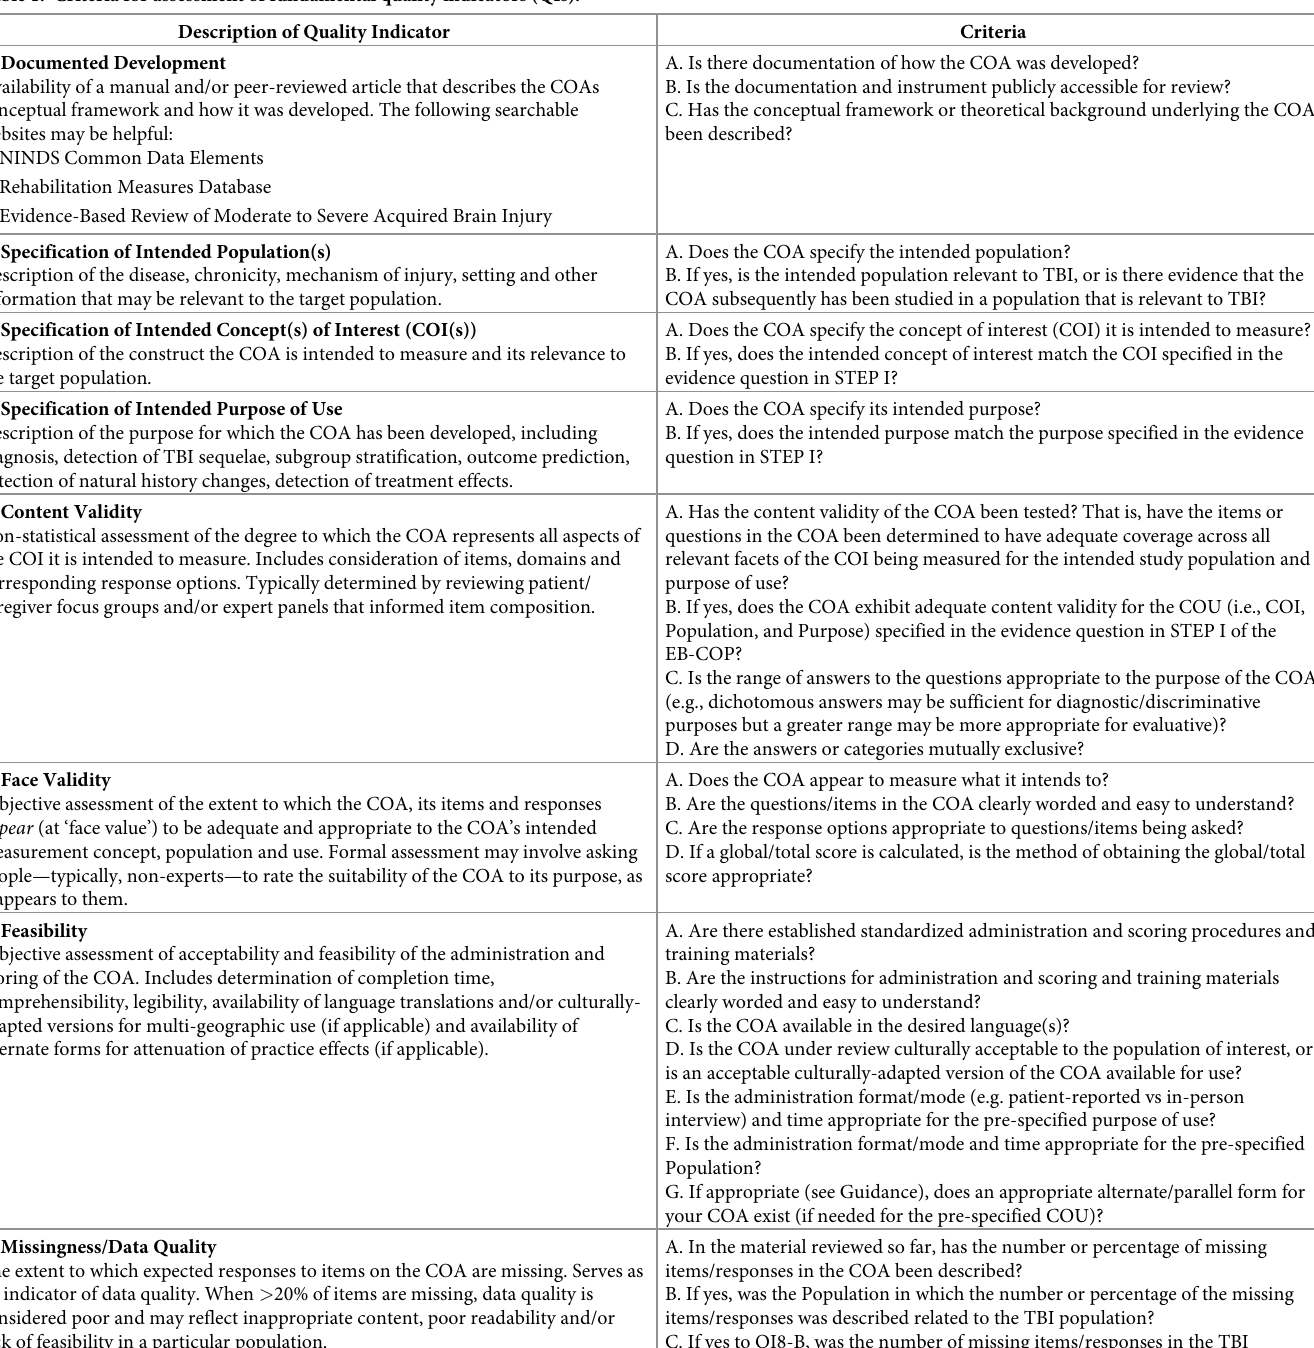
Table 1. Criteria for assessment of fundamental quality indicators